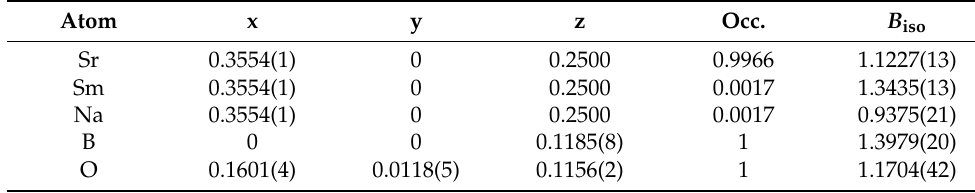
Table 1. Refined parameters of SBO:0.005Sm 3+ sample.